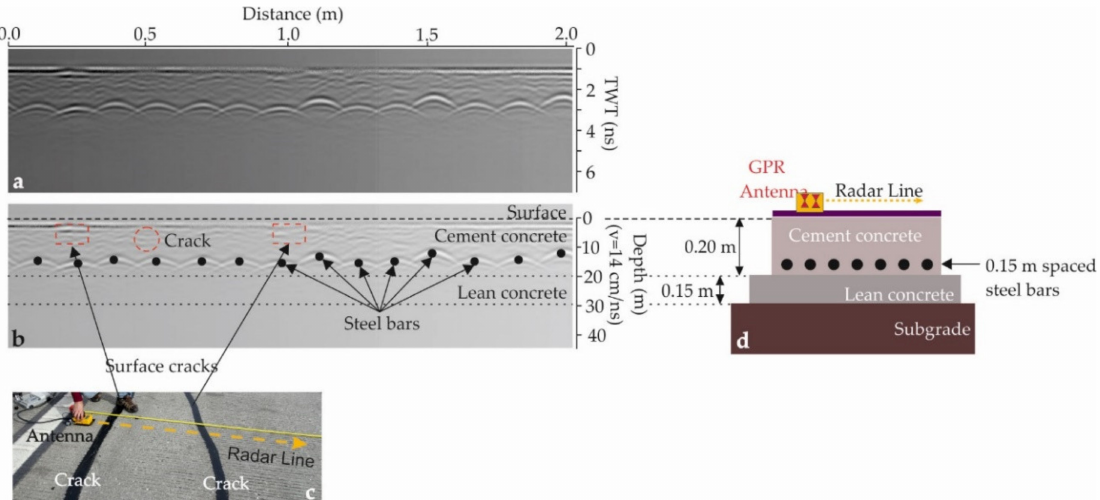
Figure 3. Results obtained in the study of rigid pavement. ( a ) Radargram. ( b ) Data interpretation highlighting the existence of cracks also visible at pavement surface ( c ) and cracks in the deeper layers, not yet visible. Moreover, image ( b ) shows the location of the rebar, the cover depth and the thickness of the different layers, obtaining a final model of the structure ( d ) (adapted from Rasol et al.